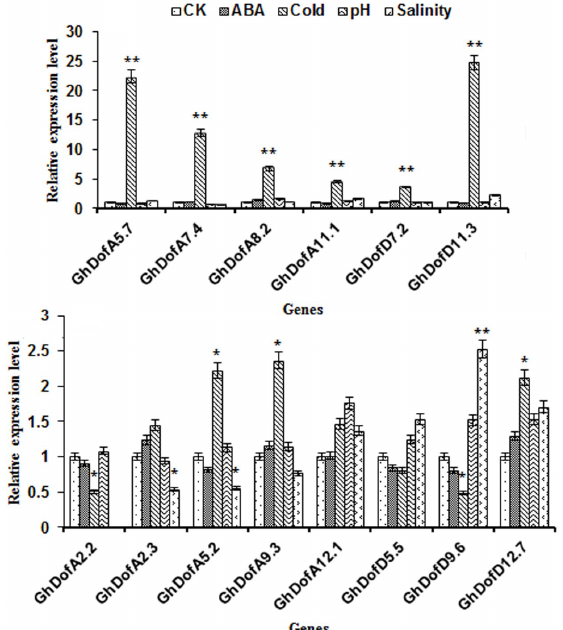
Figure 6. GhDof gene expression under ABA, cold temperature, pH, and salinity stresses. The X-axis indicates the GhDof genes.The Y-axis indicates relative expression level. The threshold cycle (Ct) values of all of the genes were normalized to the internal reference gene—a house-keeping gene ( GhHis ), the relative expression level was calculated by the 2 −ΔΔCt method. Abscisic acid (ABA), cold, pH, salinity, and control (CK) seedlings were kept on 1/2 MS medium with50 μmol L -1 ABA, a temperature of 4 °C, a pH of 11.0, 200 mmol/L NaCl, or no stress for ten days. The bars indicate SDs. * indicates significant differences at the p < 0.05 level. ** indicates extremely significant differences at the p < 0.01 level.